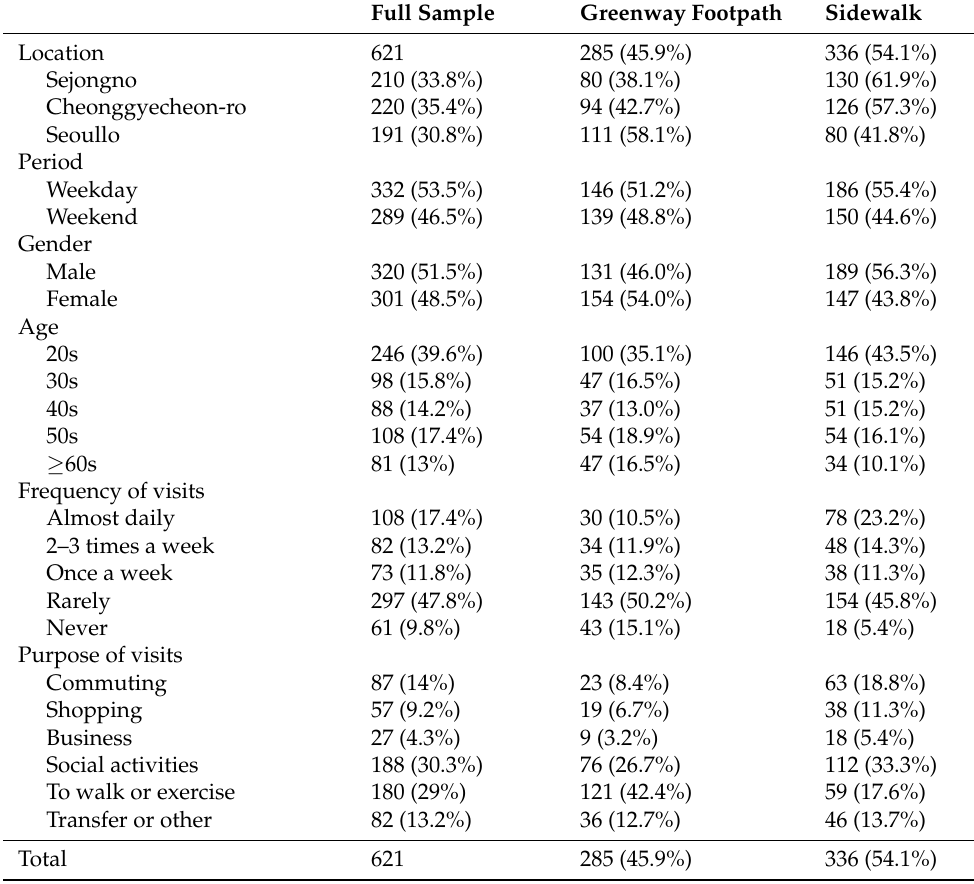
Table 2. Demographic characteristics of the